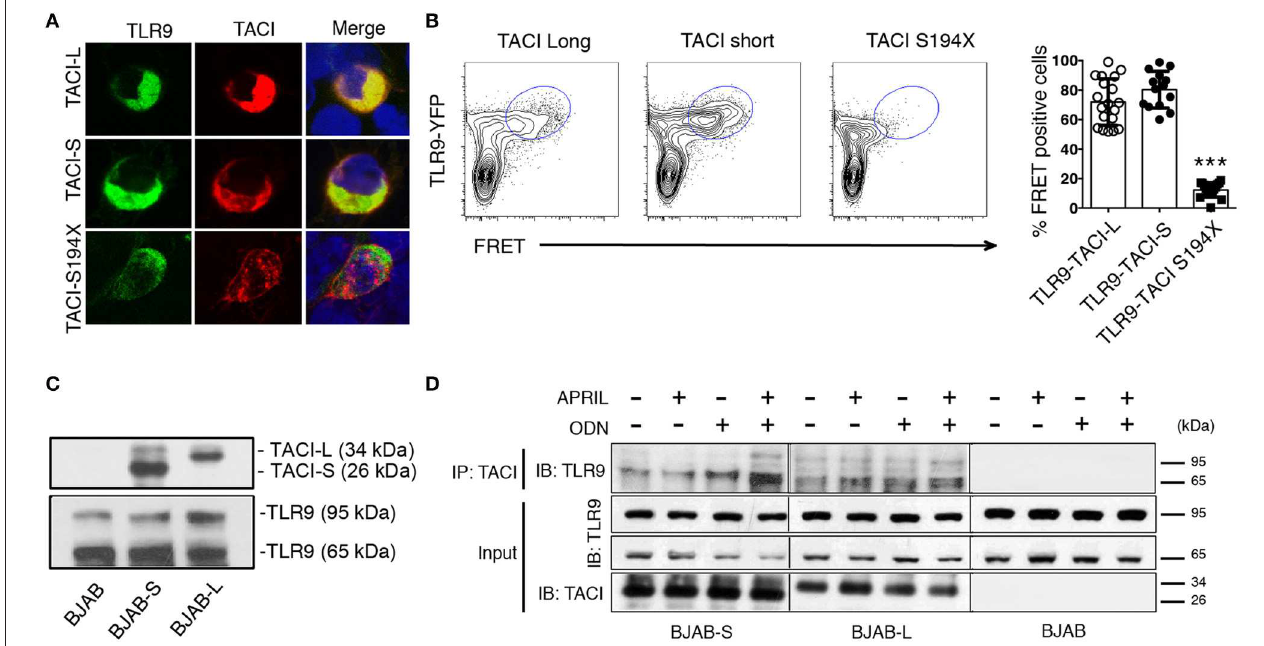
FIGURE 6 | TACI isoforms are associated with activated cleaved TLR9. (A) HEK-293T cells were transfected with either mCherry labeled TACI-S or TACI-L or the S194X mutant (red) along with TLR9-YFP (green); cells were examined by confocal microscopy showing co-localization (yellow) in cells expressing TACI-L or –S, but absent in cells with the S194X mutant. (B) HEK-293T cells were transfected with either TACI-S, TACI-L, or the S194X mutant with TLR9-YFP, to determine complex formation using FRET using FACS (LSRFortessa) as described above. Data is representative of 10 experiments. Right panel shows the % of FRET positive cells in the double positive YFP and mCherry gate in these experiments. Scatter-plot graph shows the mean ± SD. *** p < 0.001, two-tailed paired Student t -test. (C) Lysates of parental BJAB cells or stably transduced with either TACI-S or TACI-L, were examined by immunoblotting using either anti-TACI (top) or anti-TLR9 antibody (bottom) after PAGE gel electrophoresis. Blotting shows both non-activated and activated TLR9 forms (95 and 65kDa) for all cells and TACI isoforms visible only for transduced cells. (D) In other experiments, TACI-S or TACI-L BJAB cells, were incubated for 48h with APRIL, ODN, or both, were lysed and biotin-labeled goat anti-TACI complexes were collected with SA beads and immunoblotted after PAGE with anti-TLR9 antibody. The activated 65kDa TLR9 cleaved form was predominant in TACI-captured immune complexes (top panel). This effect was enhanced in BJAB-S cells on activation with ODN and even more with ODN + APRIL as activators. Lower panels show TACI and TLR9 expression for the input of these